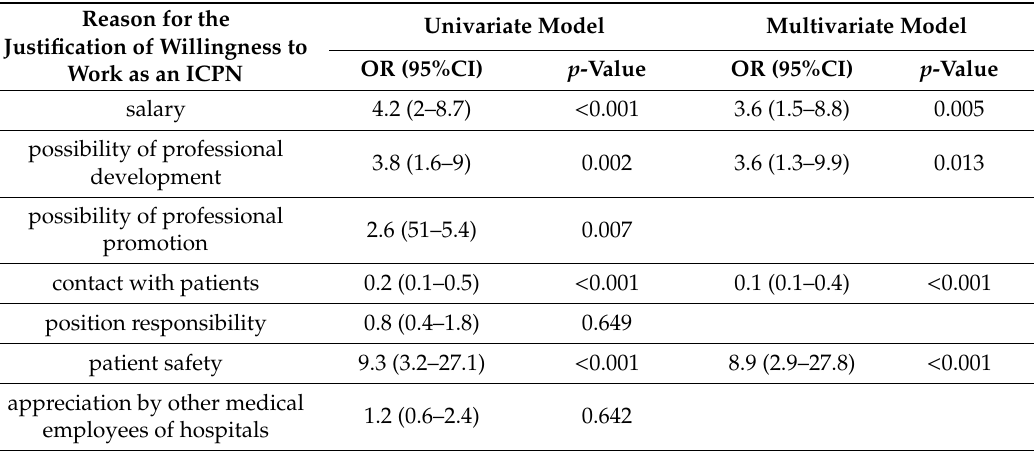
Table 5. The odds of willingness to work as an infection control and prevention nurse in relation to the importance of the listed